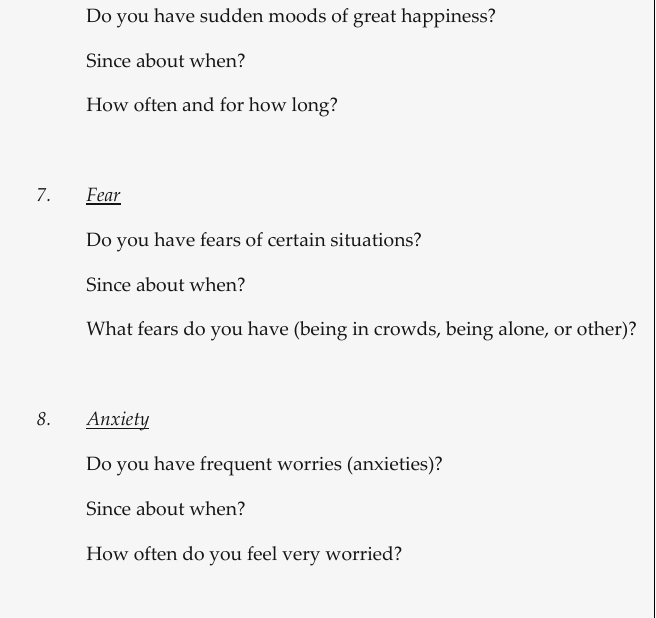
Figure 1. Set of questions from the Seizure Questionnaire (modified from: Blumer et al. [1]).